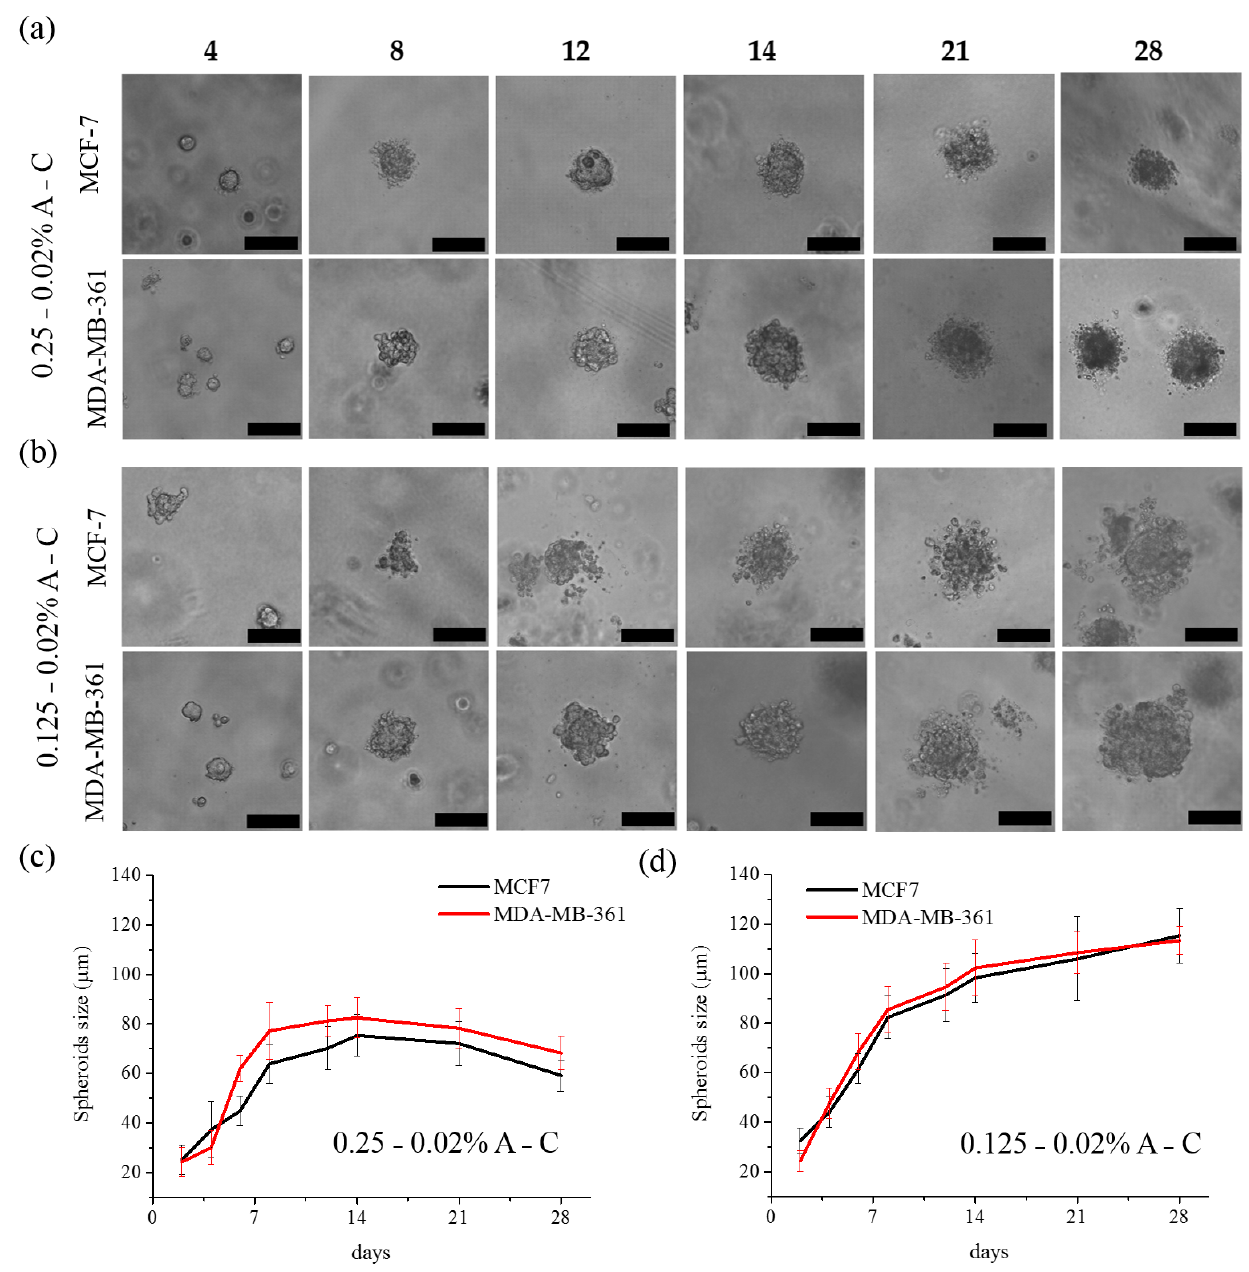
Figure 4. Optical images ( a , b ) and average size ( c , d ) of the spheroids obtained with MCF-7 and MDA-MB-361 cells grown up to 14 days either in 0.25–0.02% ( a , c ) or 0.125–0.02% ( b , d ) A-C hydrogels. Scale bar is 100 µm.